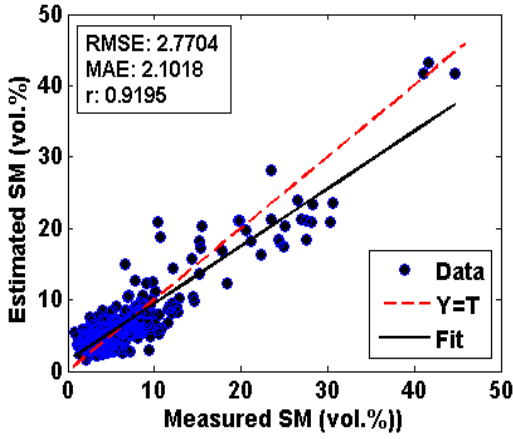
Figure 12. The relationship between measured and estimated SM for Dataset 3.